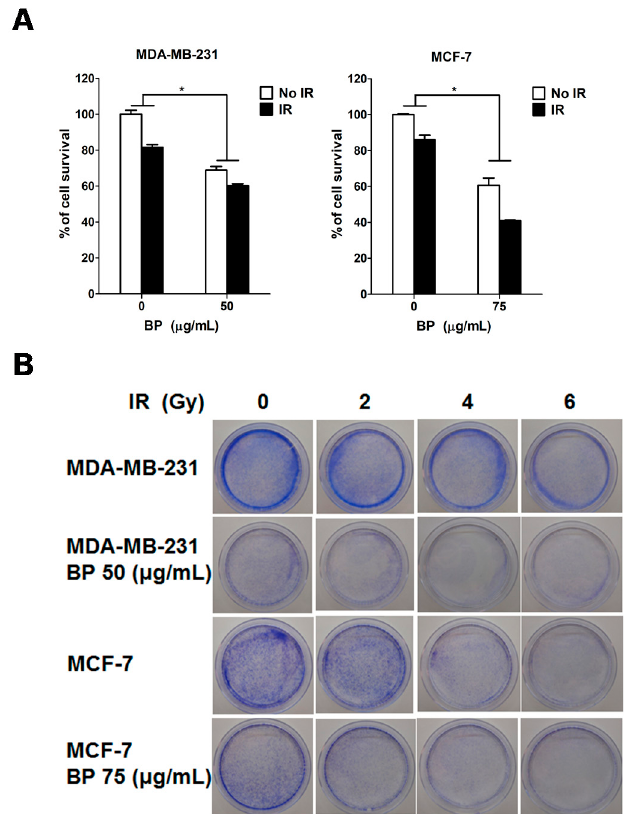
Figure 4. Cont. Figure 4.